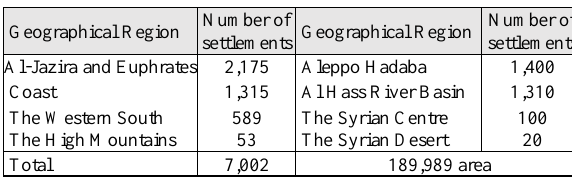
Table 1. Earthen settlements in the region of Syria.